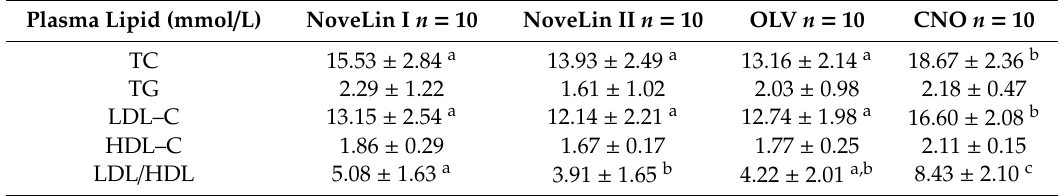
Table 5. E ff ect of dietary intervention on plasma lipid profiles of rabbits.